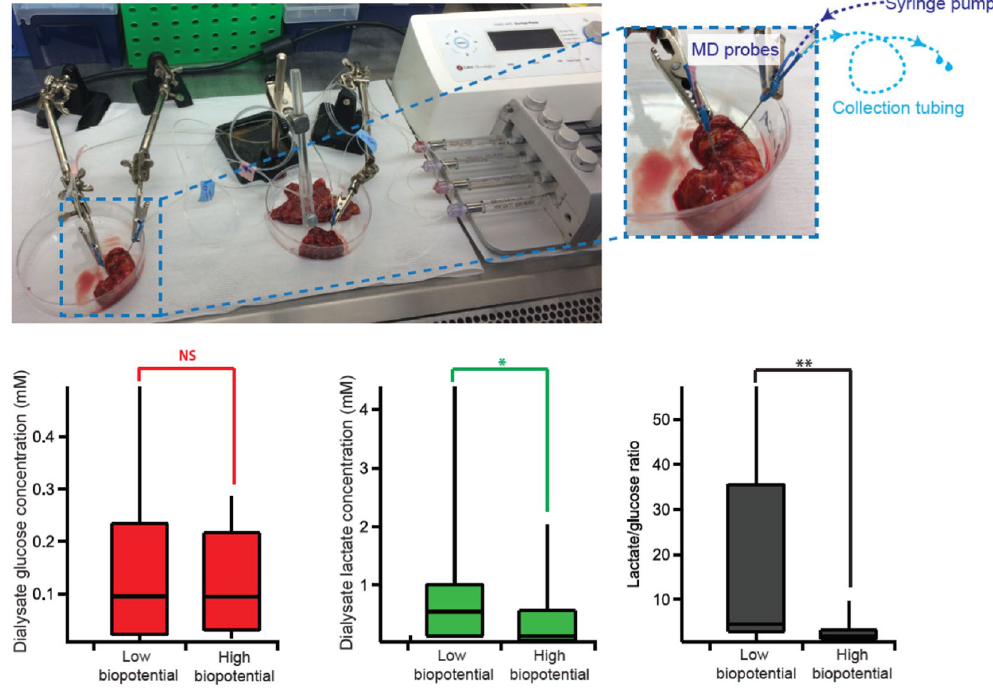
Figure 5. Laboratory setup for dialysate collection. ( a ) Two probes are inserted into non-cancerous tissue (left) and cancerous tissue (right) and perfused simultaneously using a syringe pump. The dialysate is collected in 0.75 m lengths of collection tubing. ( b ) Box and whisker diagrams comparing dialysate glucose levels (red), lactate levels (green) and lactate/glucose ratio (black) for paired omentum tissue with low and high biopotential (n = 12). Statistics tested using two-tail Wilcoxon sign rank